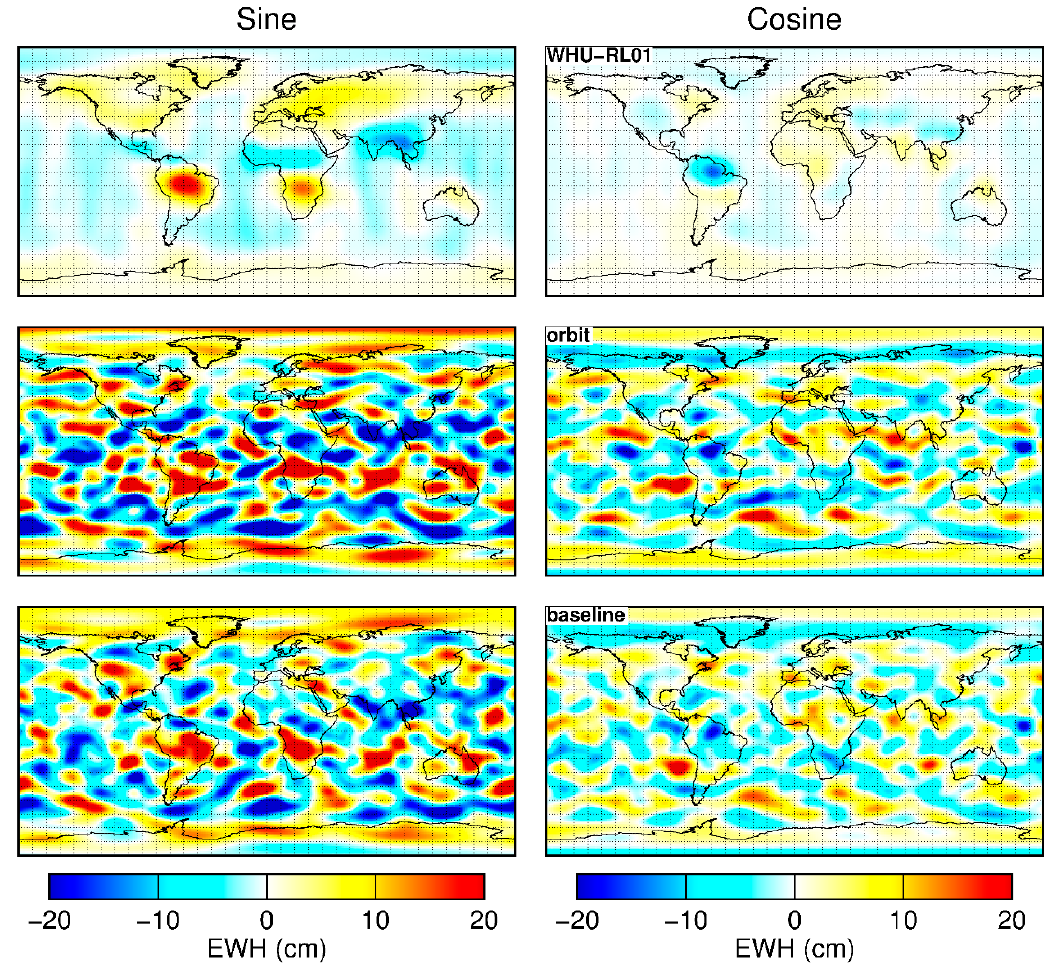
Figure 4. Periodic annual signals in mass anomalies in terms of equivalent water heights inferred from different G750 filtered solutions. From top to bottom, the plots display the results based on the WHU-RL01, orbit and baseline solutions, respectively.